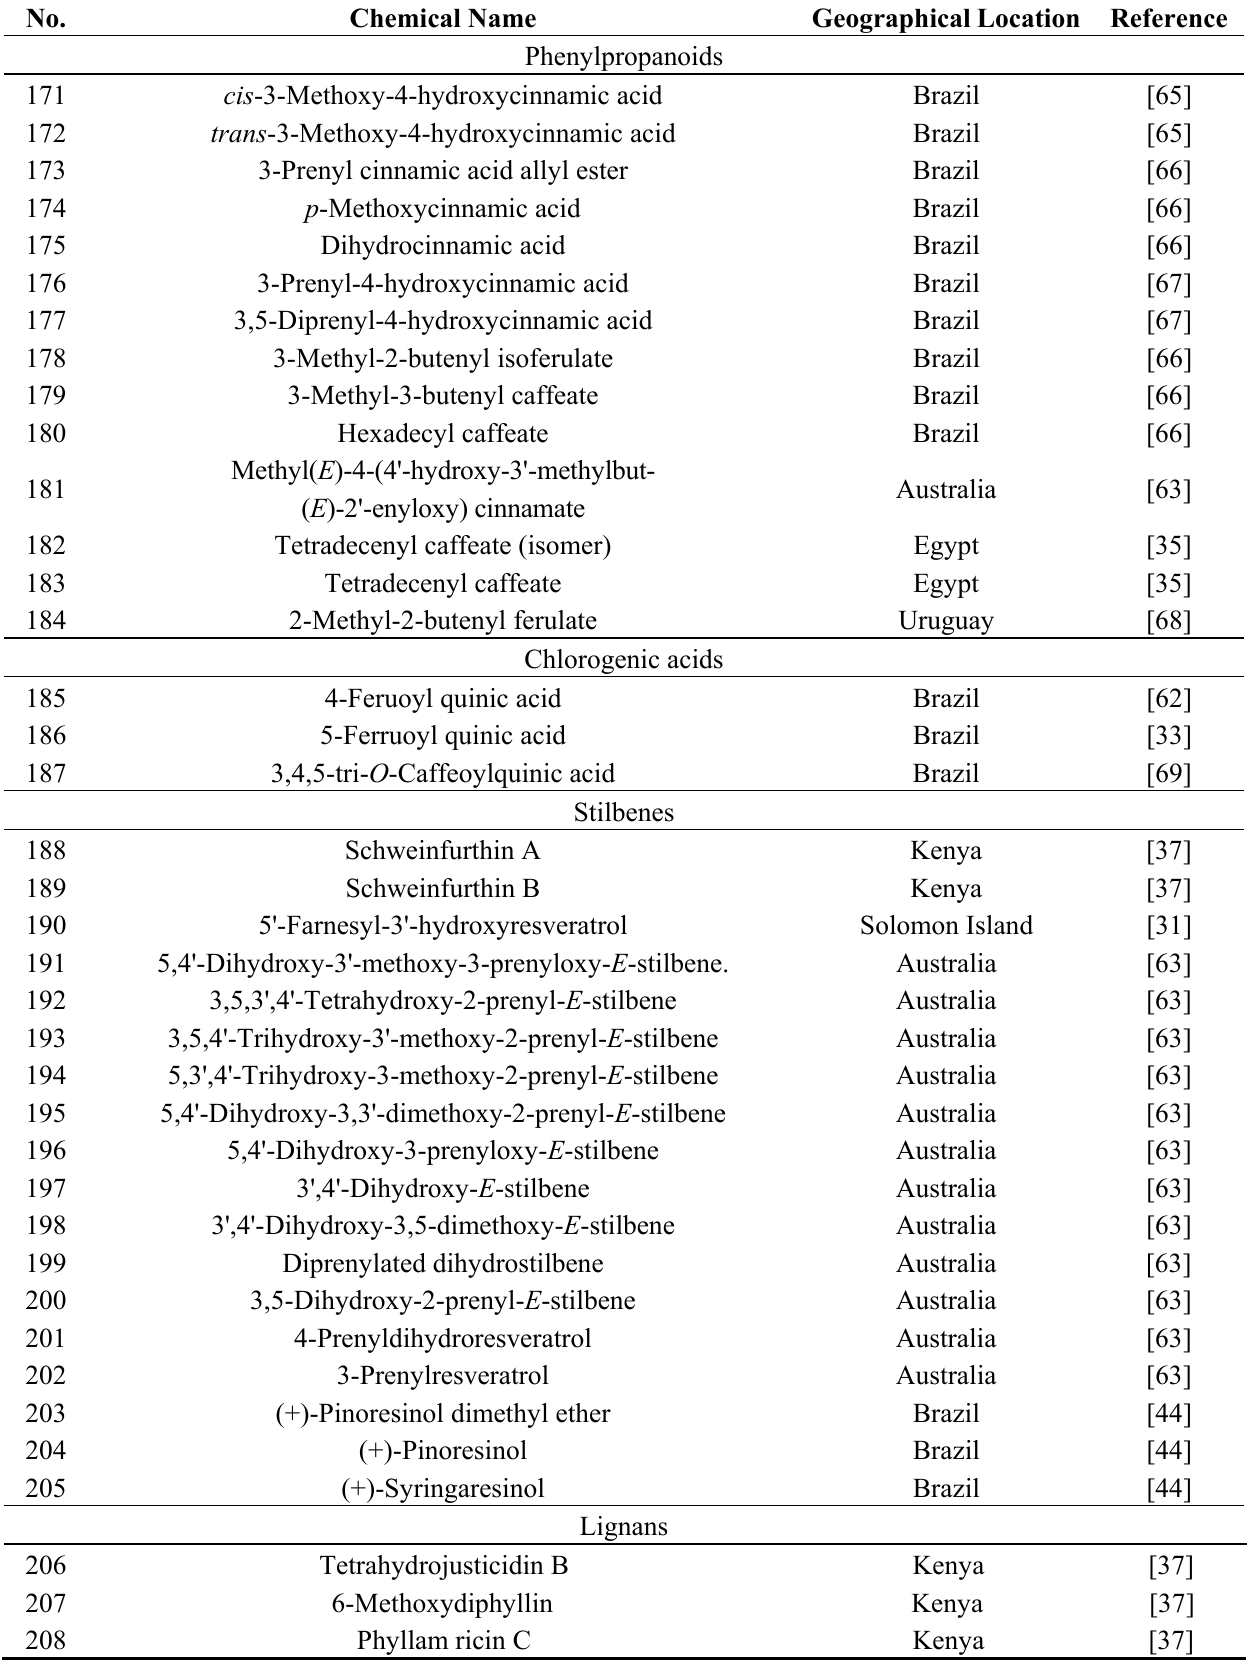
Table 3. Phenolics identified in propolis since